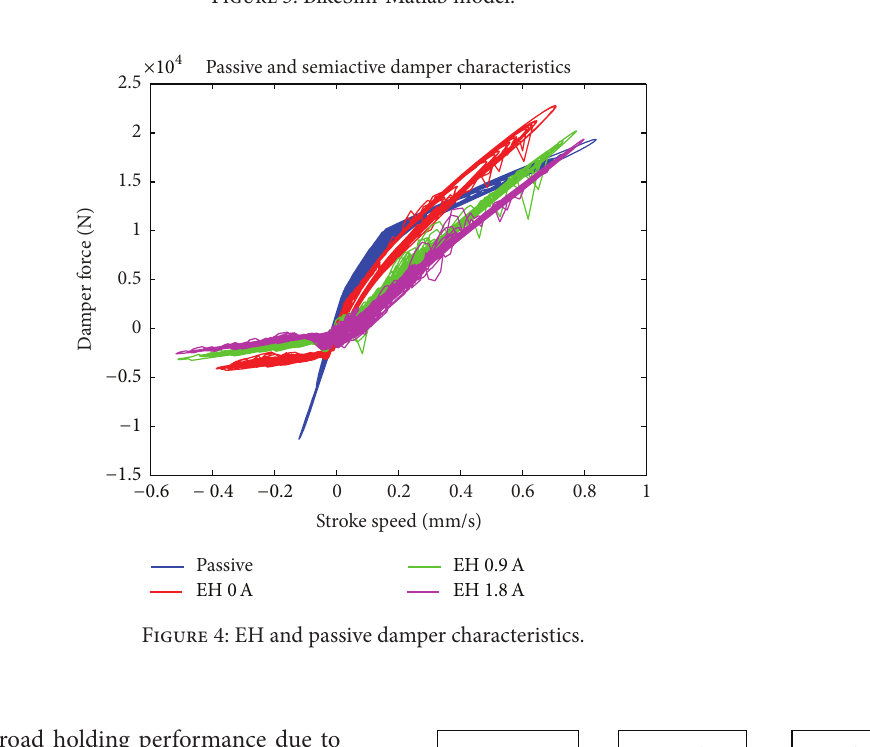
Figure 3: BikeSim-Matlab model.